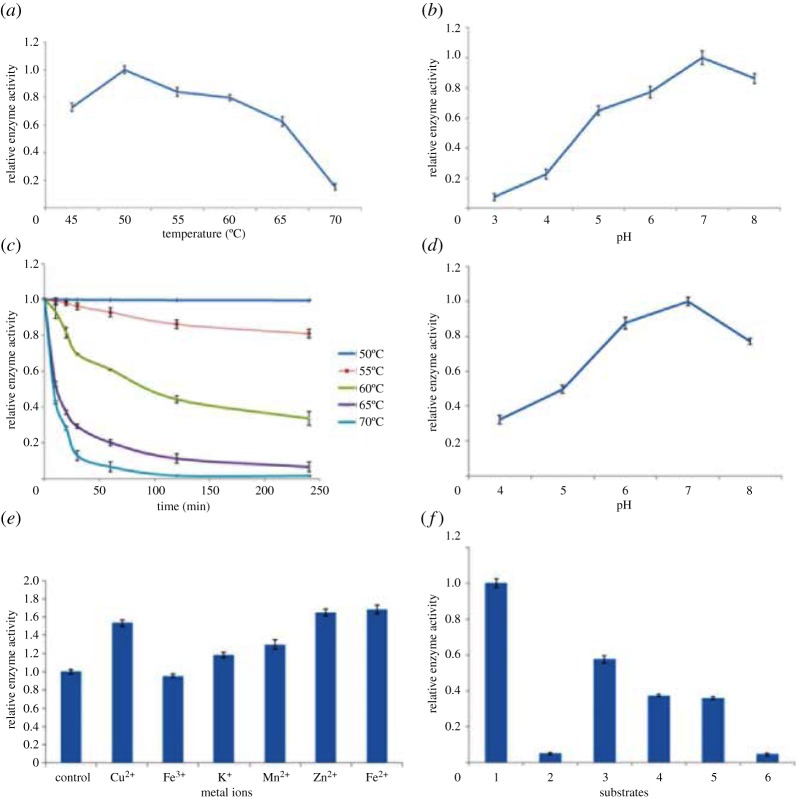
Properties of cellulase secreted by B. amyloliquefaciens S1. (a) Effect of temperature on cellulase activity; (b) effect of pH on cellulase activity; (c) thermal stability; (d) pH stability; (e) effect of metal ions on cellulase activity and (f) selectivity of cellulase to substrates. 1: CMC-Na; 2: cassava dregs; 3: absorbent cotton; 4: soya bean meal; 5: filter paper; 6: microcrystalline cellulose.